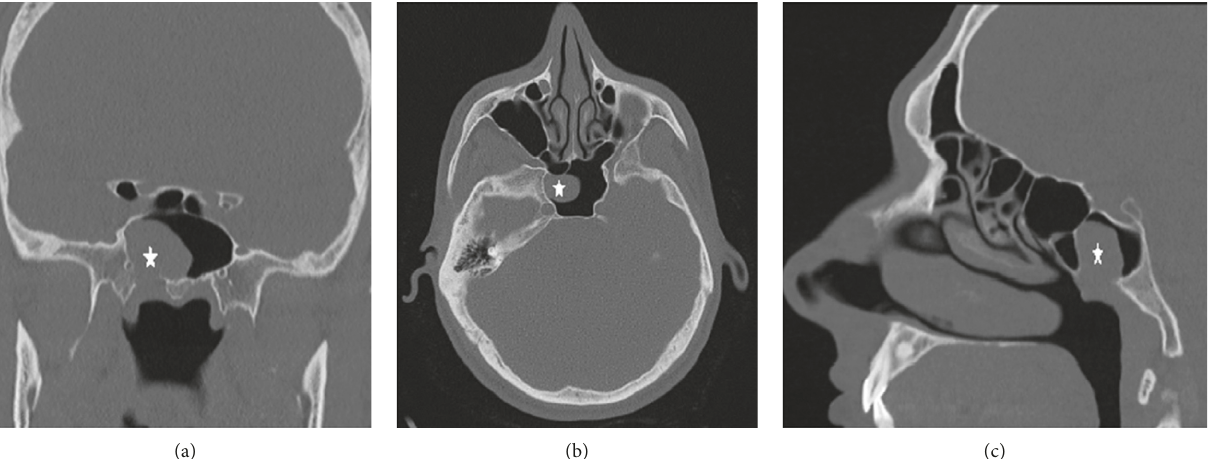
Figure 2: Computed tomography image of angiofibroma localized in the sphenoid sinus ((a) coronal, (b) axial, and (c) sagittal).